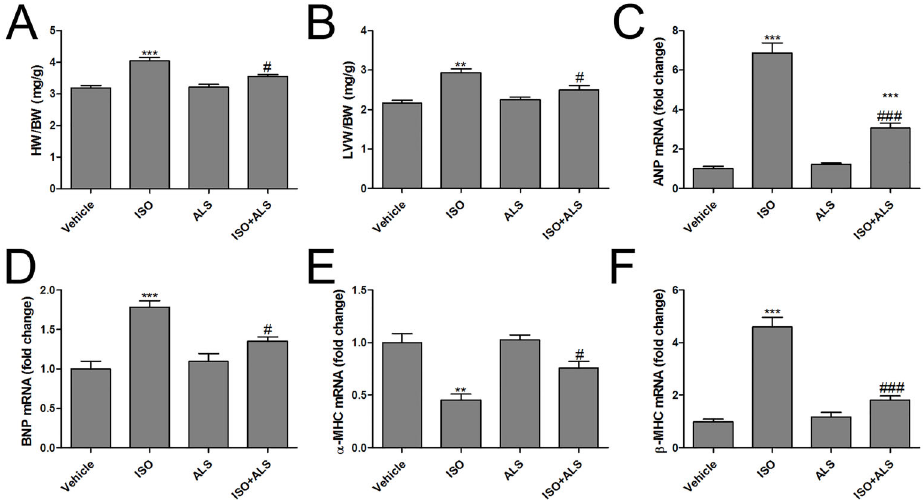
Figure 2. Canonical markers of cardiac hypertrophy in response to aliskiren (ALS) in isoproterenol (ISO)-treated rats. The ratio of ( A ) heart weight/body weight (HW/BW) and ( B ) left ventricular weight to body weight (LVW/BW), the mRNA levels of ( C ) atrial natriuretic peptide (ANP), ( D ) brain natriuretic peptide (BNP), ( E ) a -myosin heavy chain ( a -MHC), and ( F ) b -MHC were measured in the left ventricles of the rats (n=6 per group). Data are reported as means ± SE. **P o 0.01, ***P o 0.001 compared with vehicle; # P o 0.05, ### P o 0.001 compared with the ISO group (ANOVA followed by Tukey ’ s post hoc